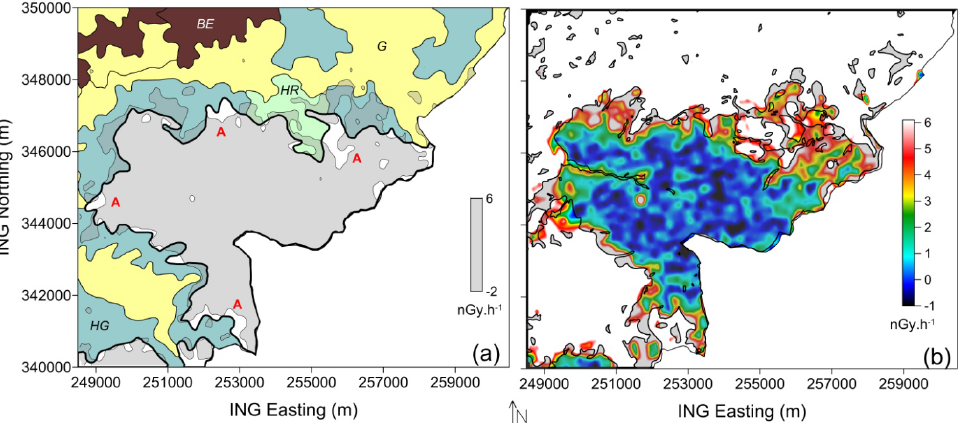
Figure 10. The 12 × 10 km study area across the Slieve Beagh blanket bog restricted to information within Northern Ireland. ( a ) Soil mapping (DARD): Peat in white (until border), BE (Brown Earth), G (Mineral Gley), HR (Groundwater Humic Ranker). Radiometric DOSE response limited to values < 6 nGy·h − 1 shown in transparent grey. Letters “A” indicate zones of mismatch (see text). ( b ) Radiometric DOSE data shown as continuous colour image, limited to 6 nGy·h − 1 . Black contours, with grey infill, denote mapped peat